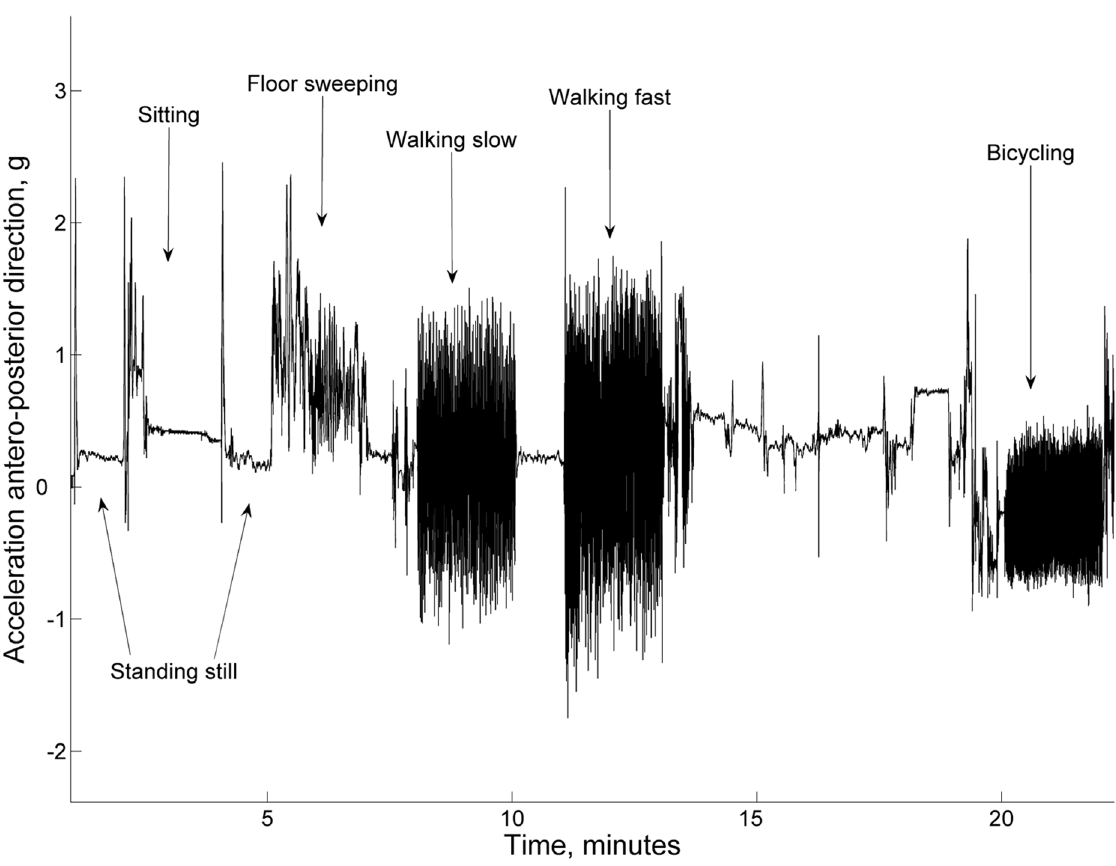
Figure 1. Acceleration signal measured using the tri-axial accelerometer during standardized activities and used to develop the classification tree. The signal represents the antero-posterior acceleration of the body during different activities and postures.